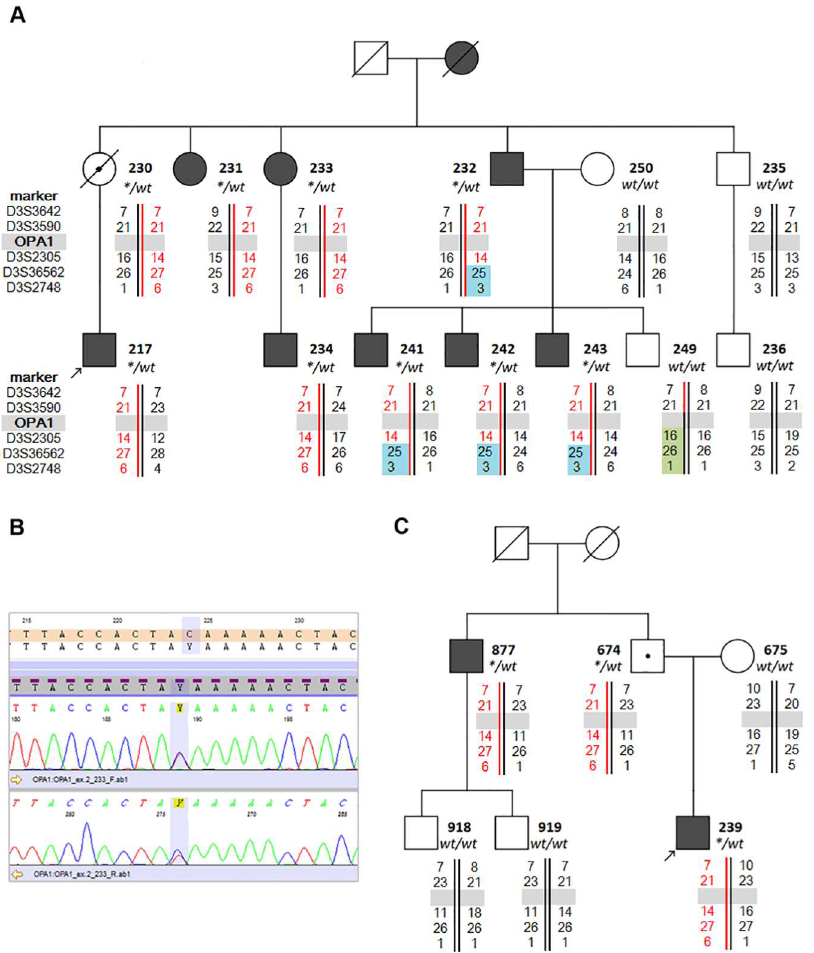
Fig 2. Identification of a novel p.Q31 * OPA1 mutation. Pedigreesof the investigatedADOA family A (A) and B (C). Probandsare indicatedby arrows. Black symbols denote affected subjects, white symbols denote unaffectedsubjectswithout OPA1 mutation. Symbols with a black dot inside refer to healthymutation carriers. Boldednumbers next to the symbols denote the respectiveDNA samples(AC). Marker names (analyzedfor both families)are shown on the left of the family A pedigree.Unboldednumbers to the right of the marker names denote microsatellite repeat motif sizes. The grey rectangle marks the location of the OPA1 gene within the 3q28–29region(AC). Wt/wt refers to patients homozygousfor the wild-typeallele, while * /wt to patients heterozygous for the p.Q31 * OPA1 mutation (AC). Electropherogramfrom Sanger bidirectional sequencing of the OPA1 exon 2 shows the c.91C > T (CAA > UAA) heterozygous mutation, predictinga premature stop codonp.Q31 * in the OPA1 protein (B).